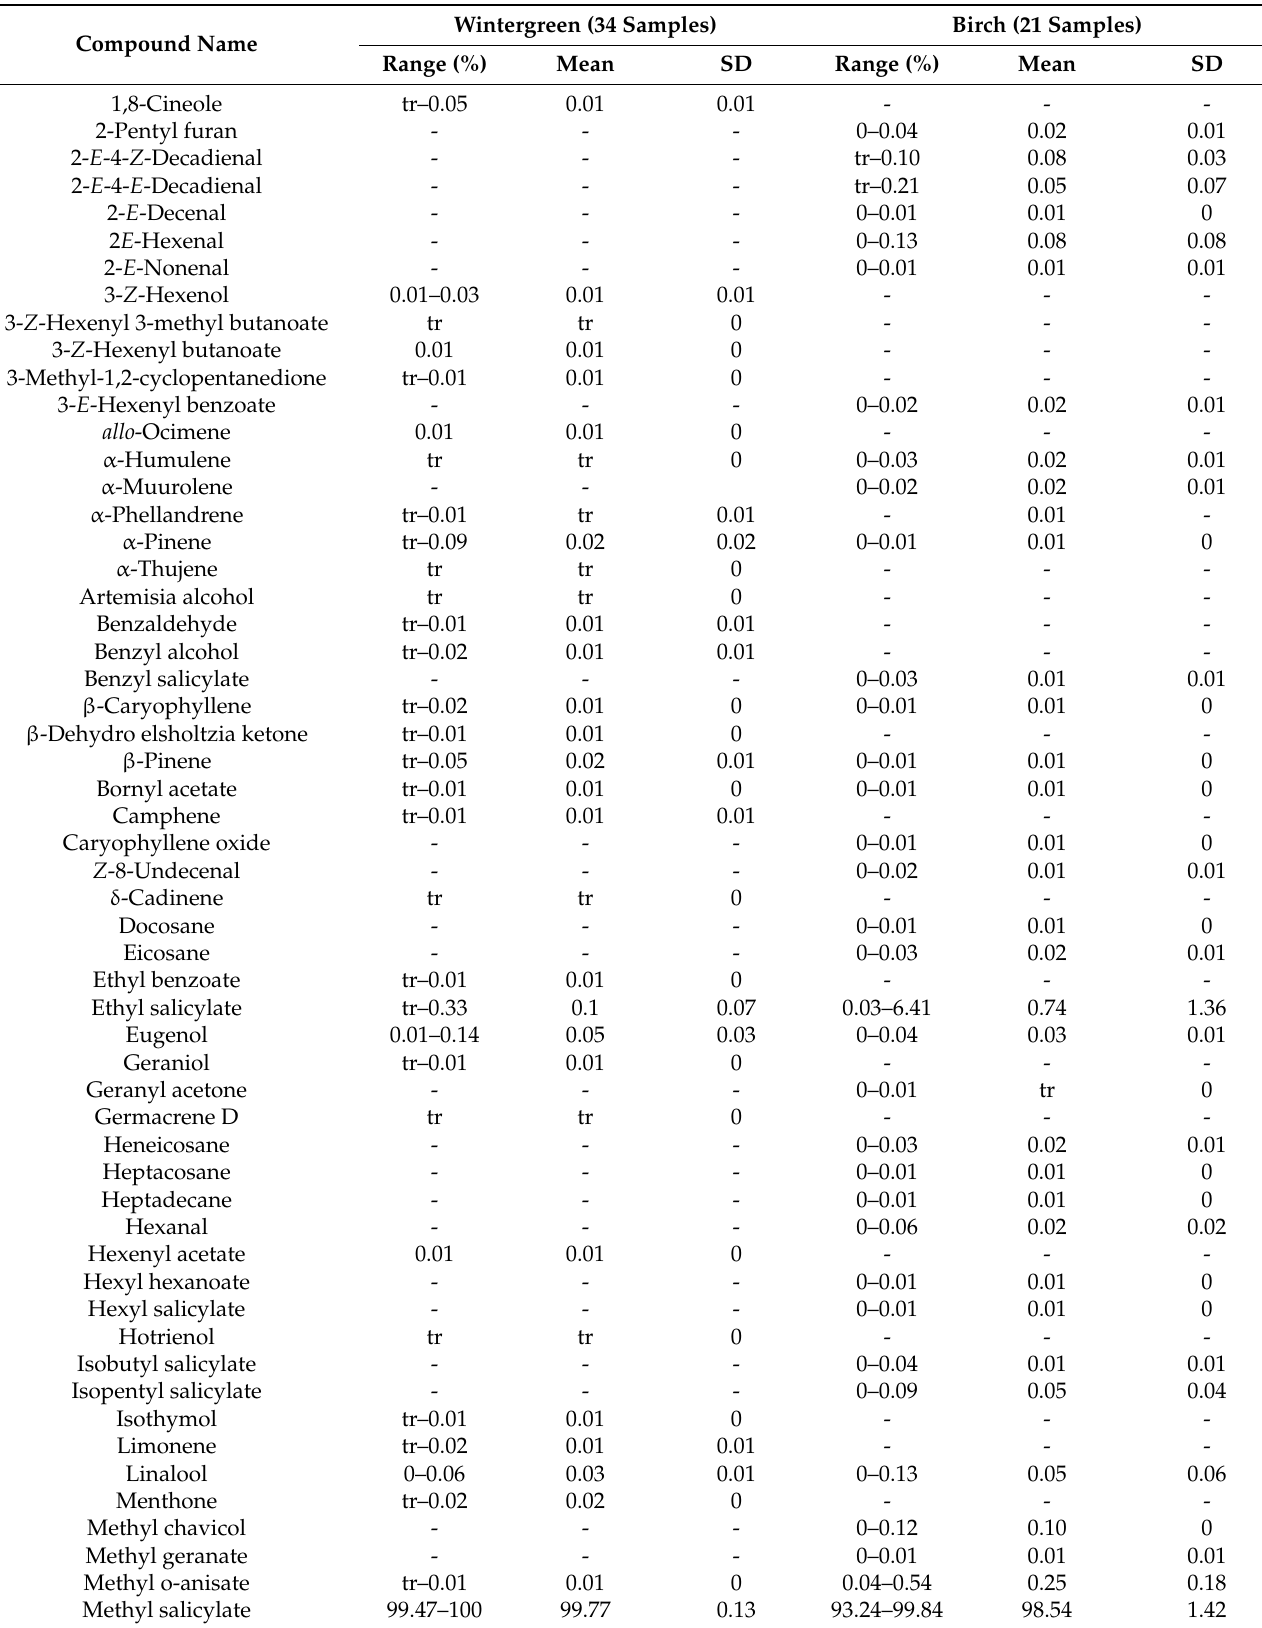
Table 3. Comparison of authentic wintergreen EOs and authentic birch